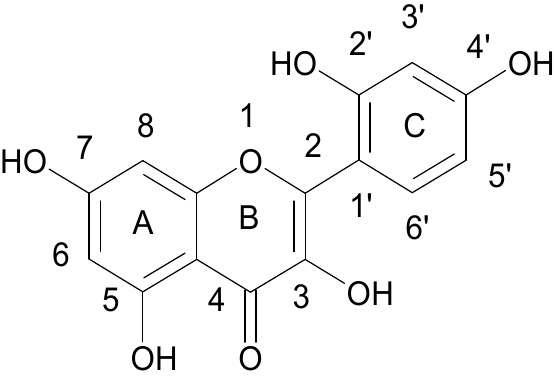
Figure 3. Chemical structure of morin.